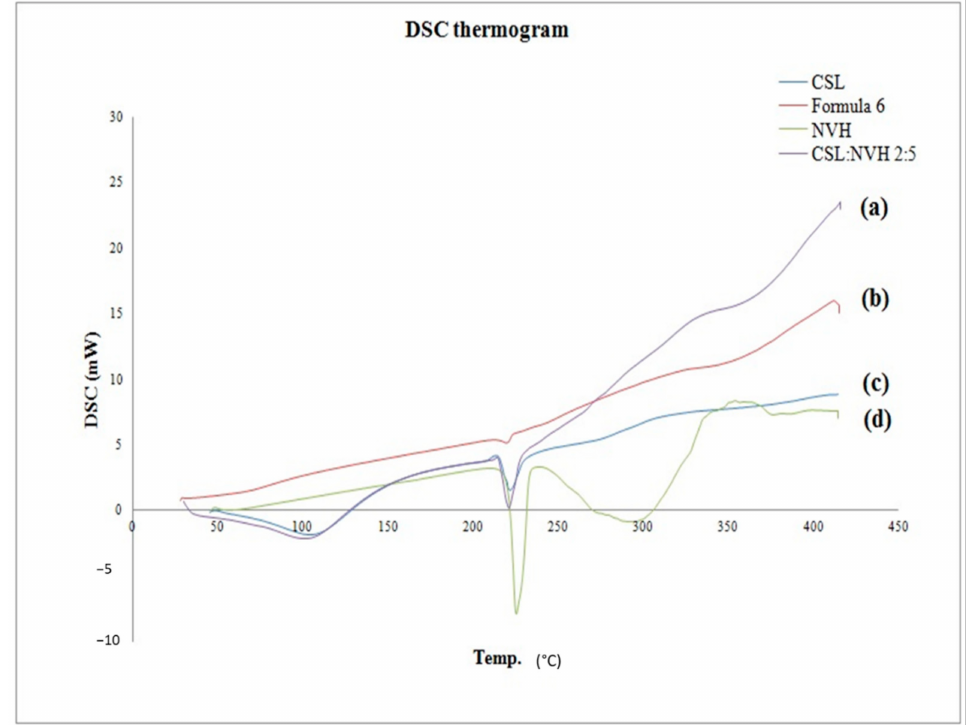
Figure 4. DSC thermograms of ( a ) physical mixture (5:2) of CSL and NVH; ( b ) lyophilized best achieved NVH-loaded chitosomal formulation F6; ( c ) CSL; ( d )